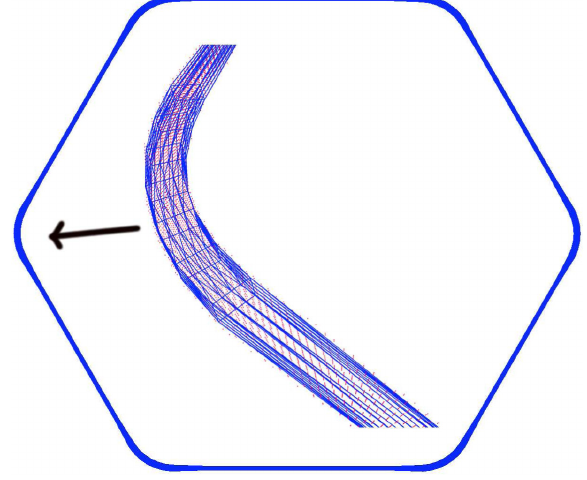
FIG. 2. Triangulated boundary of the ELENA beam region. The interior plot is an expanded 3D view of an arc. The red dots are the centers of the covering spheres located on an HCP